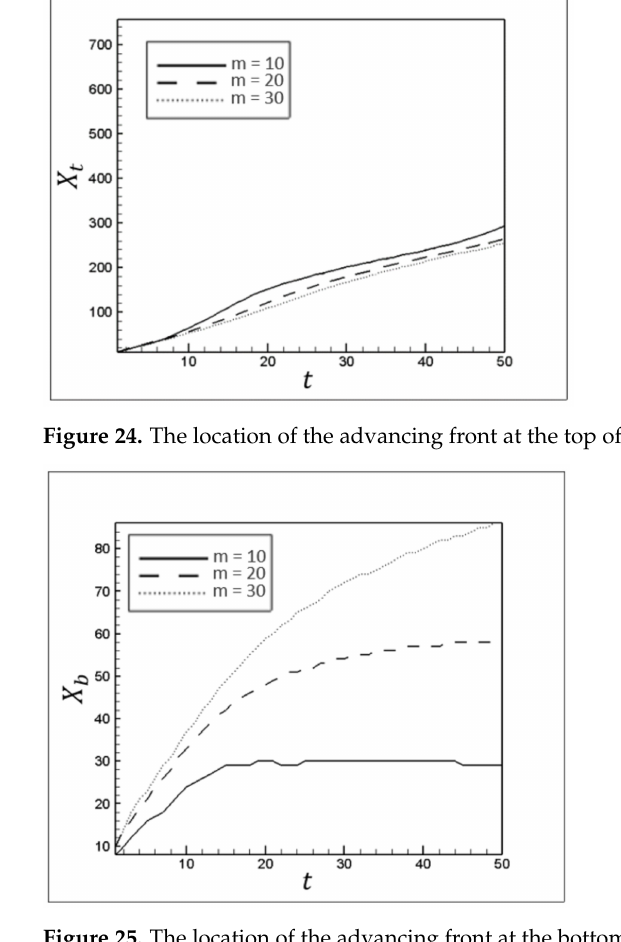
Figure 25. The location of the advancing front at the bottom of the channel over time for different m.